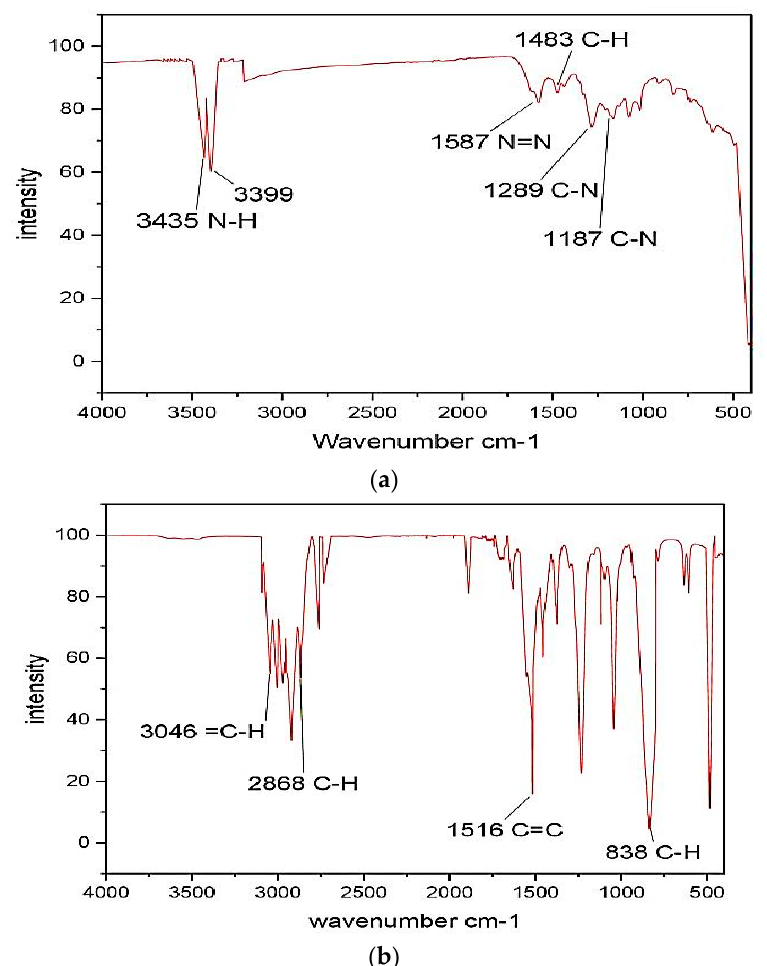
Figure 9. ( a ) Brown 706 Original dye FTIR. ( b ) Brown 706 dye FTIR after Pseudomonas aeruginosa ( a ) Brown 706 Original dye FTIR. ( b ) Brown 706 dye FTIR after Pseudomonas Degradation. aeruginosa